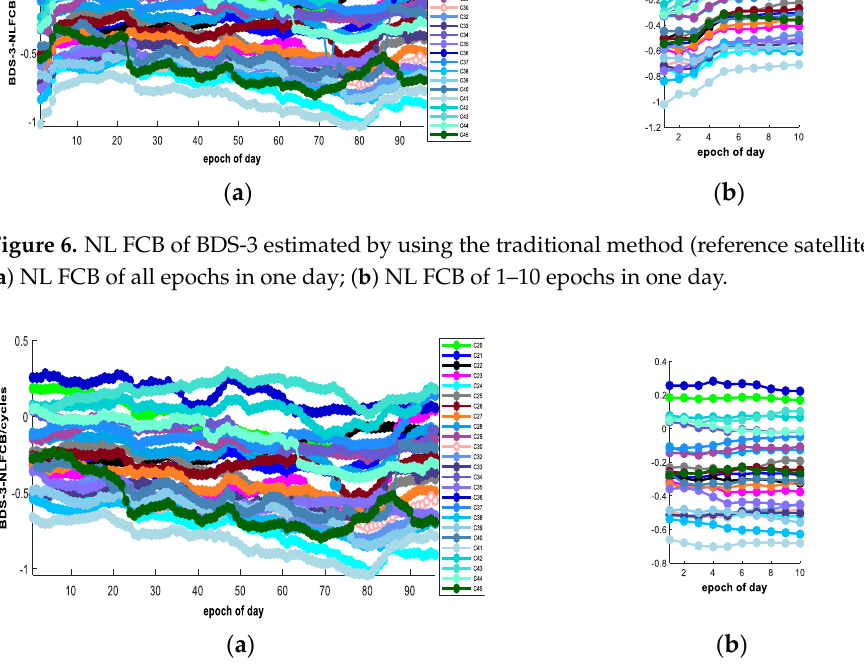
Figure 7. NL FCB of BDS-3 estimated by using the improved fast method (reference satellite is C19) as ( a ) NL FCB of all epochs in one day; ( b ) NL FCB of 1 – 10 epochs in one day. Table 2. Hardware configuration details.